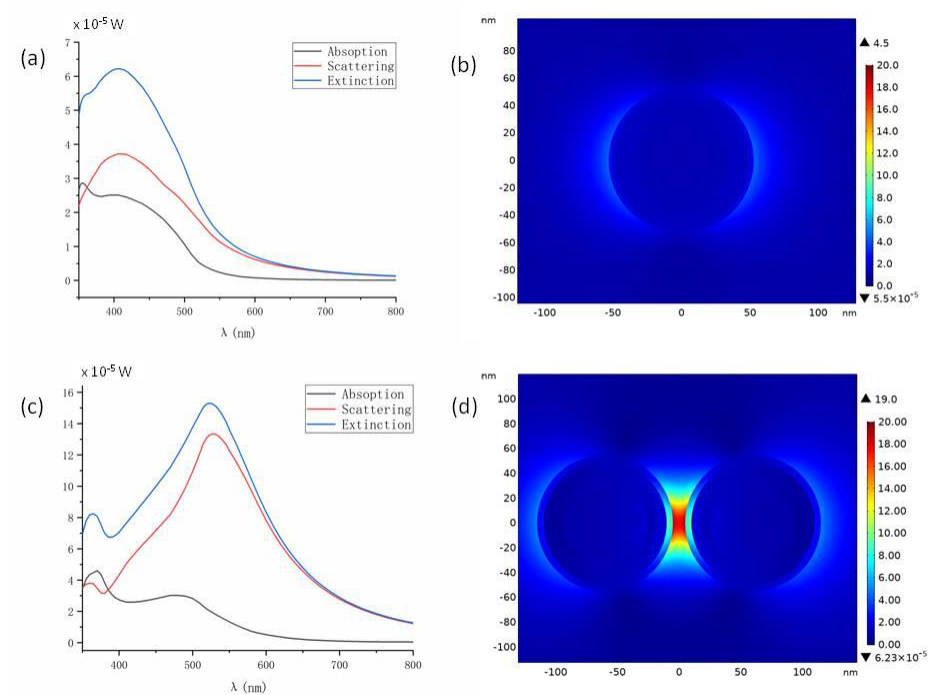
Figure 7. Electromagnetic field finite element method (FEM) stimulation for a single nanoparticle and for a dimer structure. ( a ) Scattering, absorption and extinction spectra for a single nanoparticle; ( b ) electric field enhancement distribution for a single nanoparticle at the resonance wavelength of 406 nm; ( c ) spectra for a dimer structure; ( d ) electric field enhancement distribution for a dimer structure at the resonance wavelength of 530 nm .